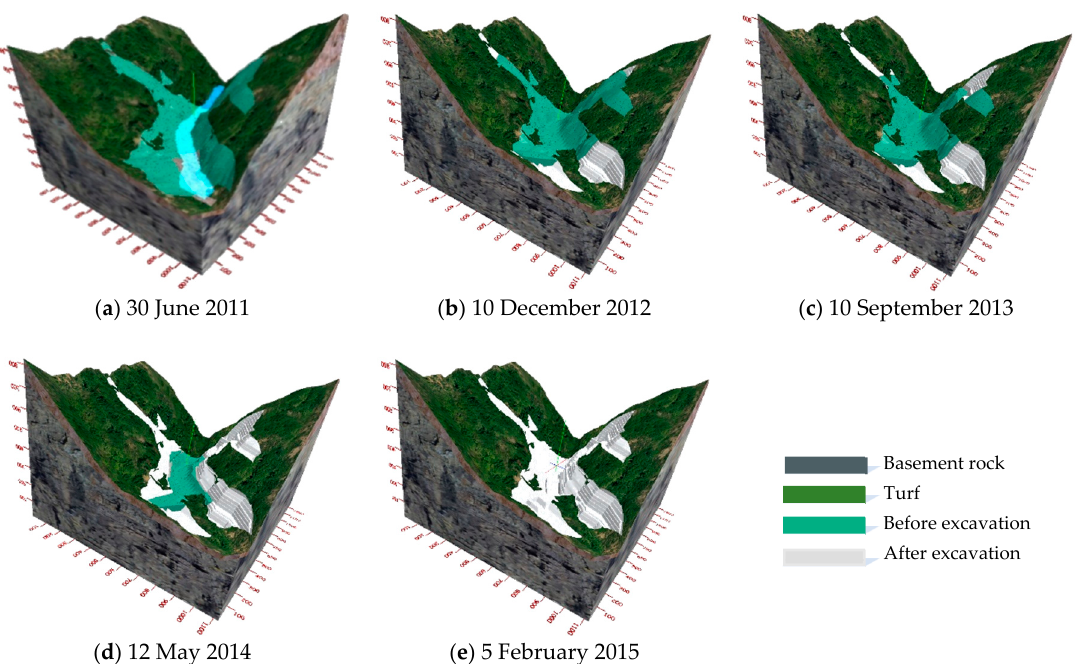
Figure 9. Visualization of the construction schedules for the slopes at different time ( a ) Construction features on 30 June 2011; ( b ) Construction features on 10 December 2012; ( c ) Construction features on 10 September 2013; ( d ) Construction features on 12 May 2014; and, ( e ) Construction features on 2 February 2015.